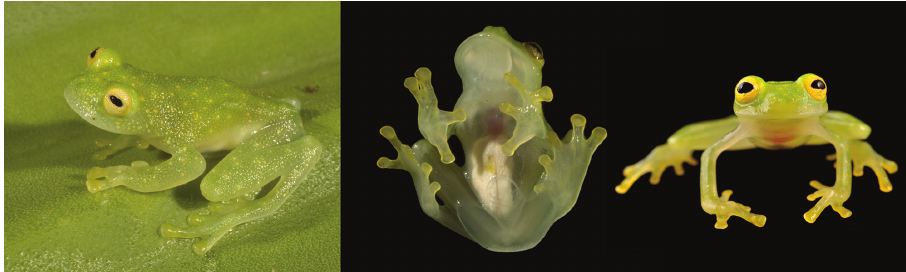
Figure 3. Hyalinobatrachium pellucidum in life. Left and center: QCAZ 4200. Right: QCAZ 41648. Photos by L. A.